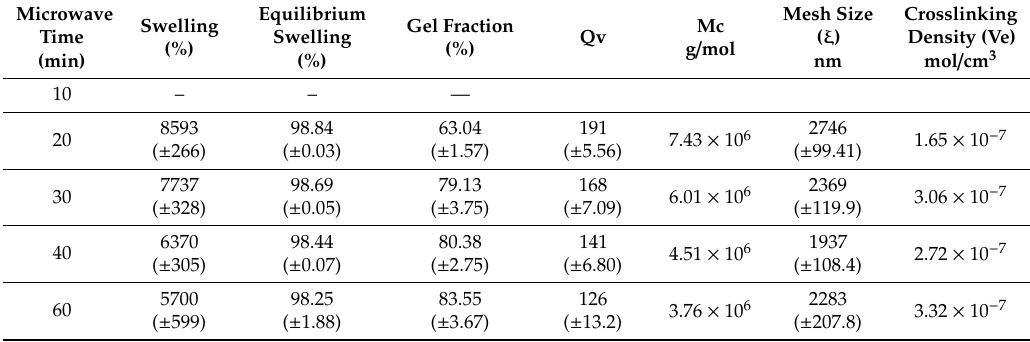
Table 4. Swelling, mesh size, and cross-linking behaviour of HA5-PT10 hydrogels crosslinked by the microwave method.